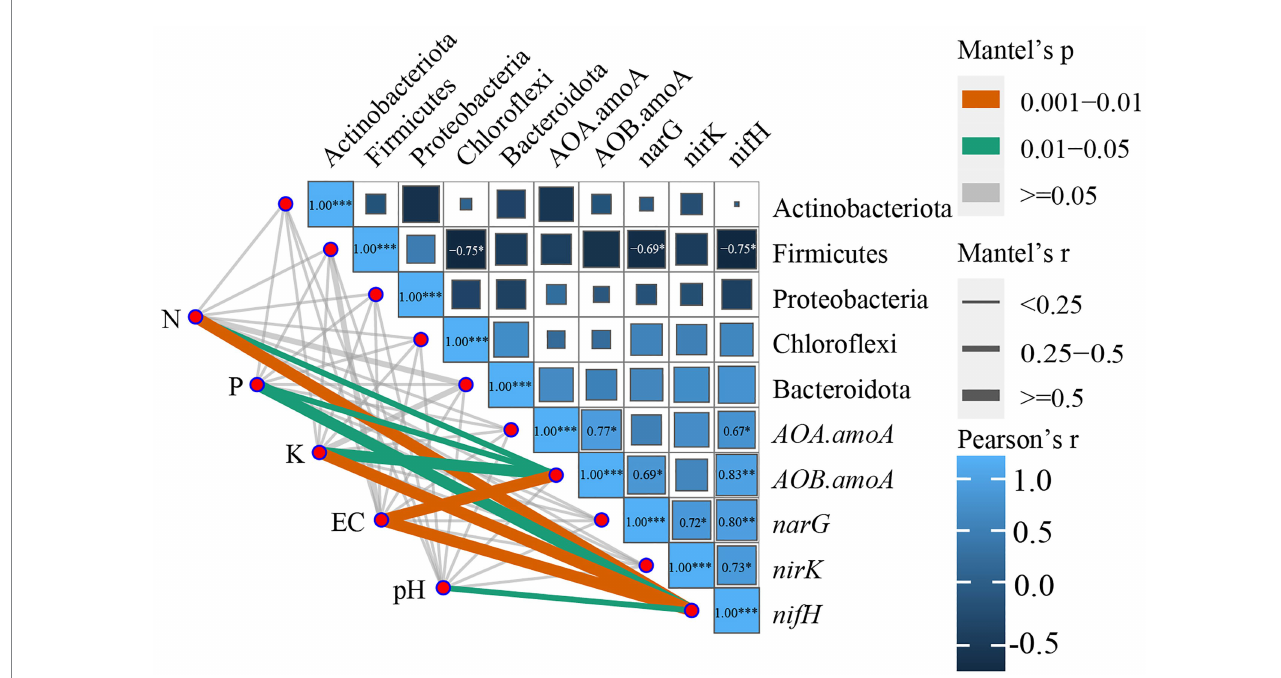
FIGURE 7 Correlation analysis of functional genes of the nitrogen cycle with environmental factors and the dominant bacterial community. * p ≤ 0.05, ** p ≤ 0.01, *** p ≤ 0.001. Only significant correlations are presented as colored lines, and the color of the line corresponds to the strength of the significance of the correlation; the thickness of the line represents the magnitude of the Mantel test r